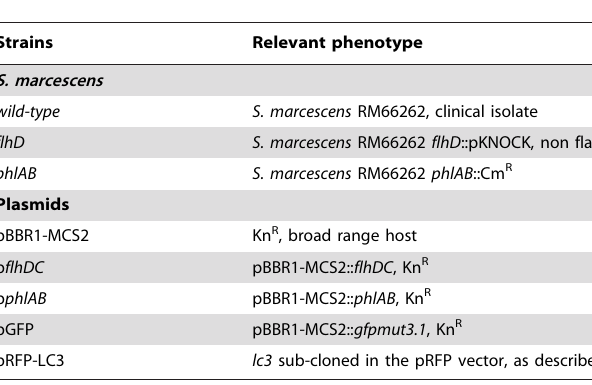
Table 1. Strains and plasmid used in this